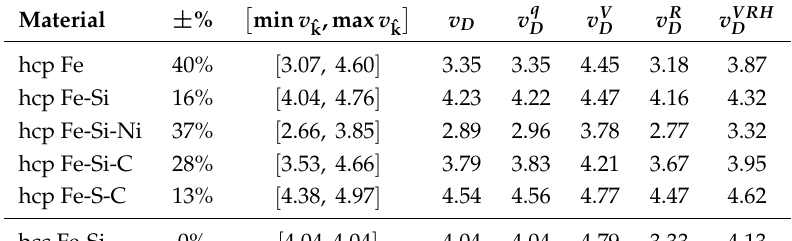
Table 2. Exact and approximate Debye speeds calculated from the elastic tensor elements of hcp and bcc iron alloys (column 1). Percent variation (column 2) of the difference of the extreme values of v ˆ (column 3) with respect to the average of the extreme values due to variations in ˆ k are given. k The true Debye speed v D (column 4), and the approximate Debye speed obtained using the analytical expressions for c m given in the Appendix A (column 5) are compared. The last three columns give the values obtained using Equation (3) where the elastic moduli κ and µ are estimated using the Voigt, Reuss, and Voigt-Reuss-Hill averages, respectively. The speeds are all in units of km/s.